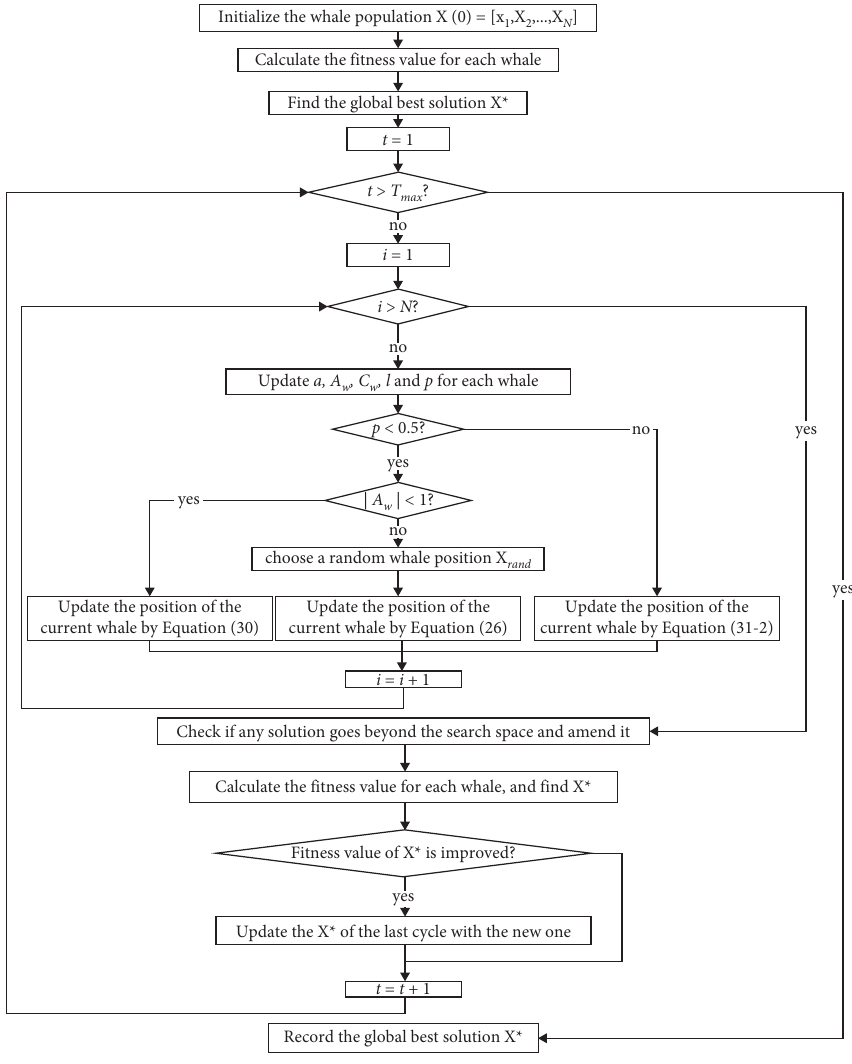
Figure 1: Flowchart of